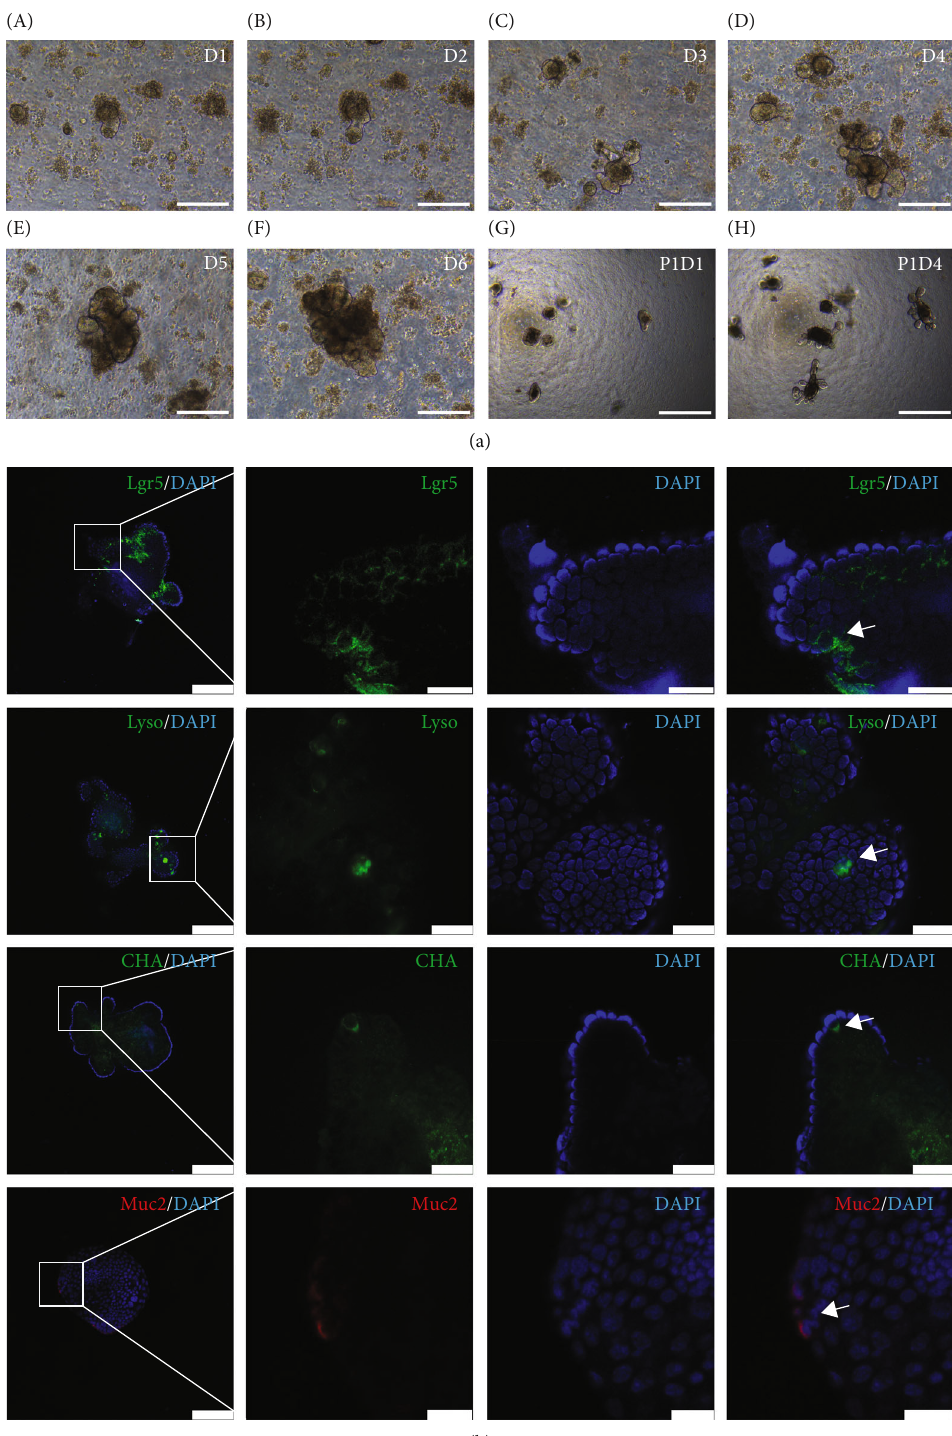
Figure 1: The growth trajectory and epithelial cell type identi fi cation of intestinal organoids. (a, A – F) Primary culture of intestinal organoids, images taken at day 1, day 2, day 3, day 4, day 5, and day 6, respectively. Scale bars = 200 μ m. (a, G – H) Passage culture of intestinal organoids, images taken at day 1 and day 4. Scale bars = 500 μ m. (b) The cell type diversity of intestinal organoids identi fi ed by immuno fl uorescence staining. Confocal image for Lgr5 (green, intestinal stem cell), lysozyme (Lyso, green, Paneth cell), chromogranin A (CHA, green, intestinal endocrine cell), and Muc2 (red, goblet cell). DAPI (blue) for nucleus. The arrows pointed to the positive cells. Scale bars = 100 μ m ( fi rst column). Scale bars = 20 μ m (second, third, and fourth